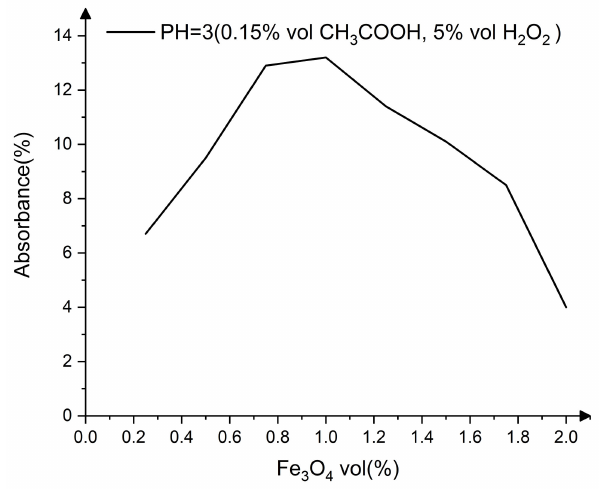
Figure 4. Effect of Fe 3 O 4 concentration on